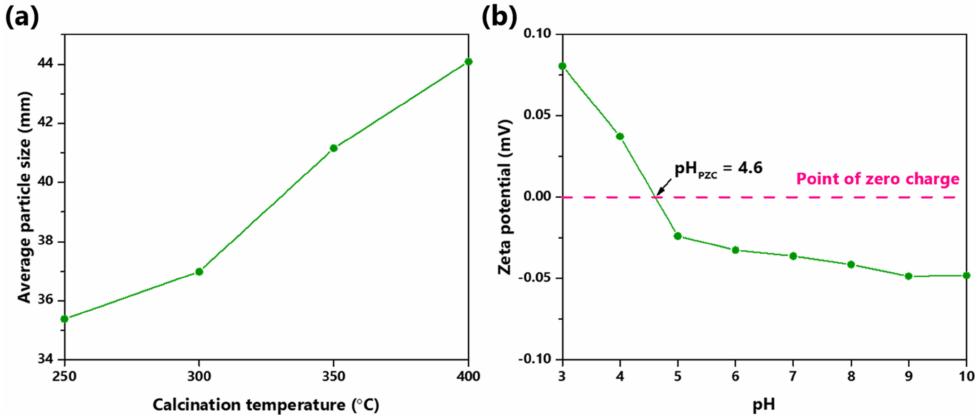
Figure 5. ( a ) Average particle size of calcined NiO particles at different temperatures and ( b ) Zeta potential of 52-300BLF at different pH